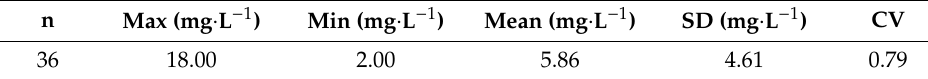
Figure 5. Results of the SSC laboratory testing. Table 2. Descriptive statistics for the SSC of the water samples from BR dataset.